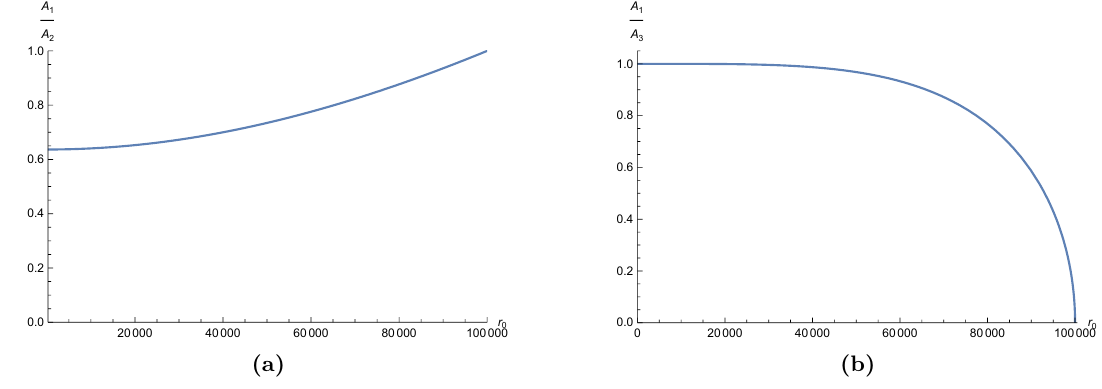
Figure 12. Plot of A 1